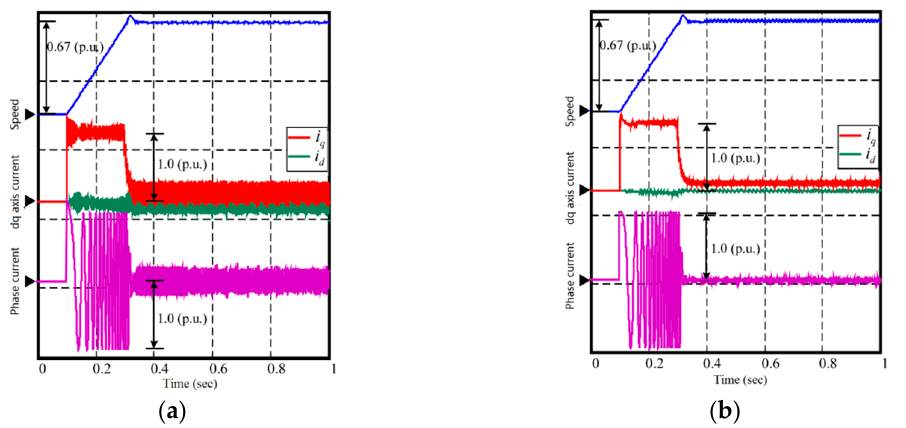
Figure 5. Simulation results of motor starting with mismatched inductance: ( a ) TBC; ( b ) AIBC_FP.